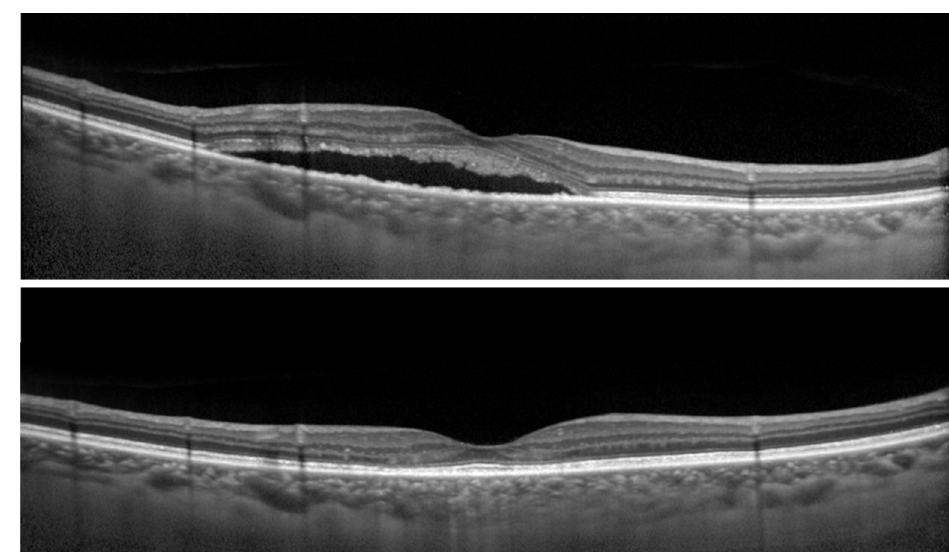
Figure 2. Optical coherence tomographic (OCT) images of the right eye of a 68-year-old man with central serous chorioretinopathy (CSC). (Top) Before reduced-fluence photodynamic therapy (RFPDT) and (Bottom) at 12 months after RFPDT. Complete resolution of SRD was observed after RFPDT. The 100% contrast visual acuity (decimal visual acuities) before and 12 months after RFPDT was 1.5, respectively. On the other hand, the 6% contrast visual acuity (decimal visual acuities) after RFPDT was 0.5. The symptom of duration was 11 months. The outer nuclear layer thicknesses before and after RFPDT were 69.0 and 92.0 μm, respectively. Table 4. Correlation between 6% contrast visual acuities after reduced-fluence photodynamic therapy and clinical parameters at pre- and